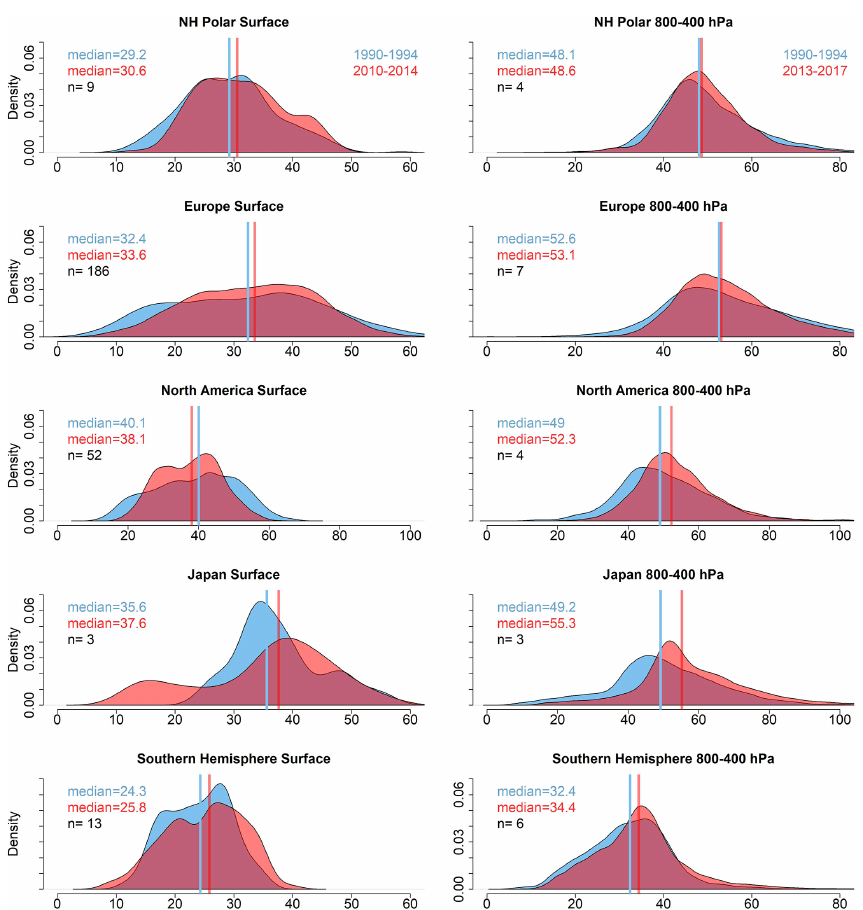
Figure 4. Changes in ozone concentration (ppb) distributions between the first 5 years of analysis (red; 1990–1994) and the last 5 years of analysis (blue; 2010–2014 for surface; 2013–2017 for sondes), shown as density functions at the surface (background sites compiled by TOAR) and throughout the troposphere (all ozone values measured by ozonesondes in the pressure range 800 to 400hPa). Median concentrations are shown with vertical lines, and the corresponding values and number of sites are recorded